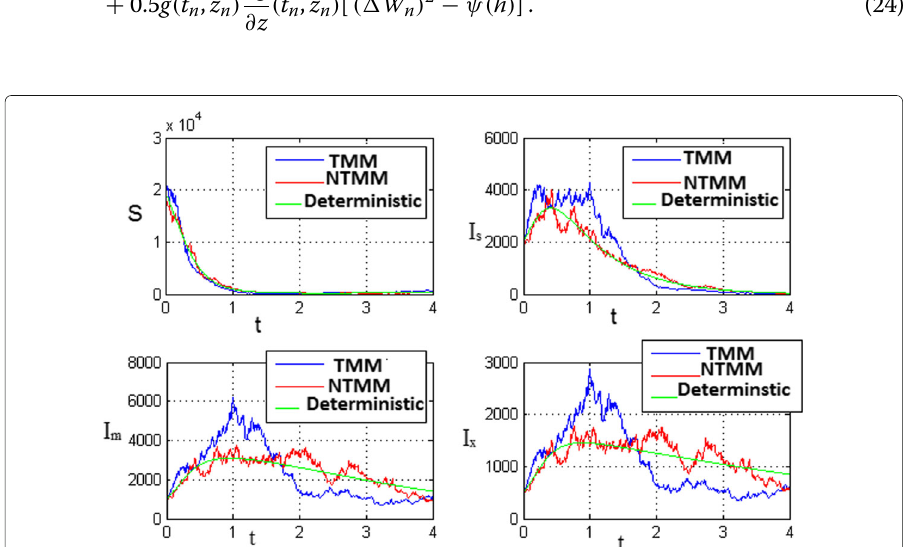
Fig. 5 The approximate solutions with ξ = 0.5, θ = 1, h =